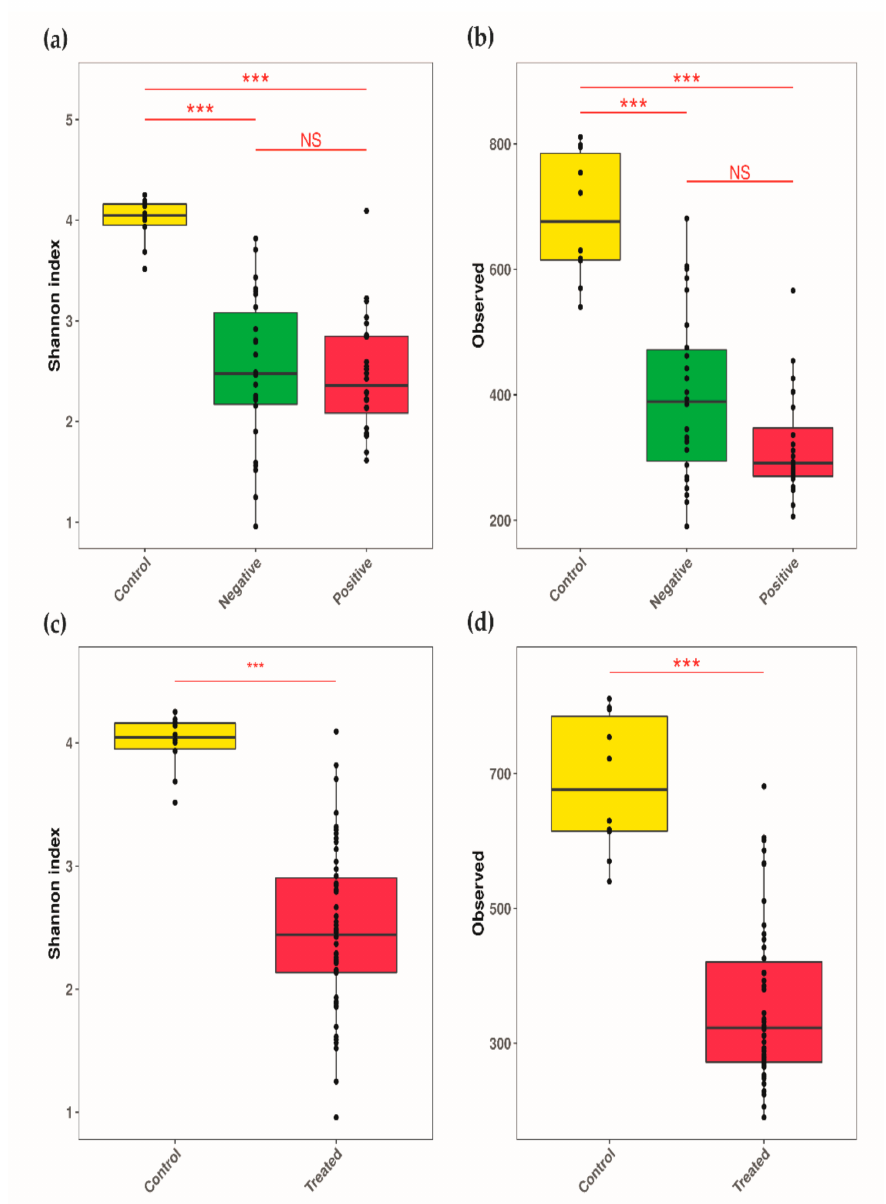
Figure 1. Boxplots based on observed species and Shannon indices showing the alpha-diversity of microbial communities. ( a ) Comparison of observed species between the CRE-based groups. ( b ) Comparison of Shannon indices between the CRE-based groups. ( c ) Comparison of observed species between antibiotic-treated and control samples. ( d ) Comparison of Shannon indices between antibiotic-treated and control samples. Within-sample diversity was compared between the CRE- based group samples using Kruskal–Wallis followed by Dunn’s post hoc test. Comparisons between antibiotic groups were performed using the Wilcoxon test. An adjusted or nominal p -value threshold of 0.05 was used to define statistical significance. *** (adjusted) p -value < 0.001; NS